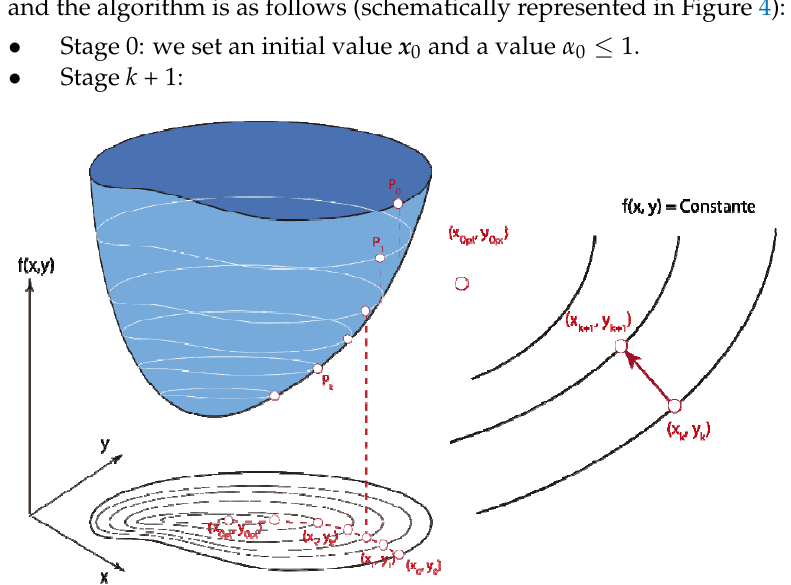
Figure 4. Gradient algorithm performance.